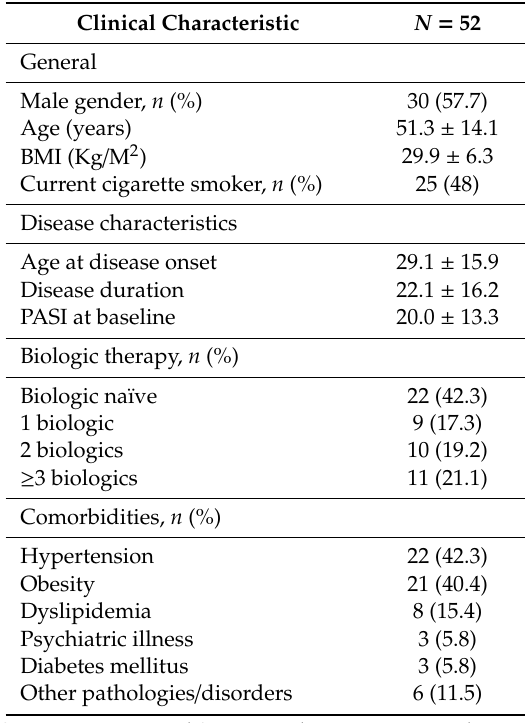
Table 1. Baseline clinical characteristics of psoriasis